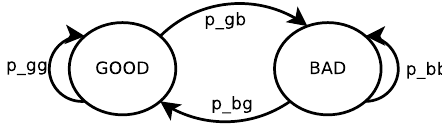
Figure 6. Two-state channel model.